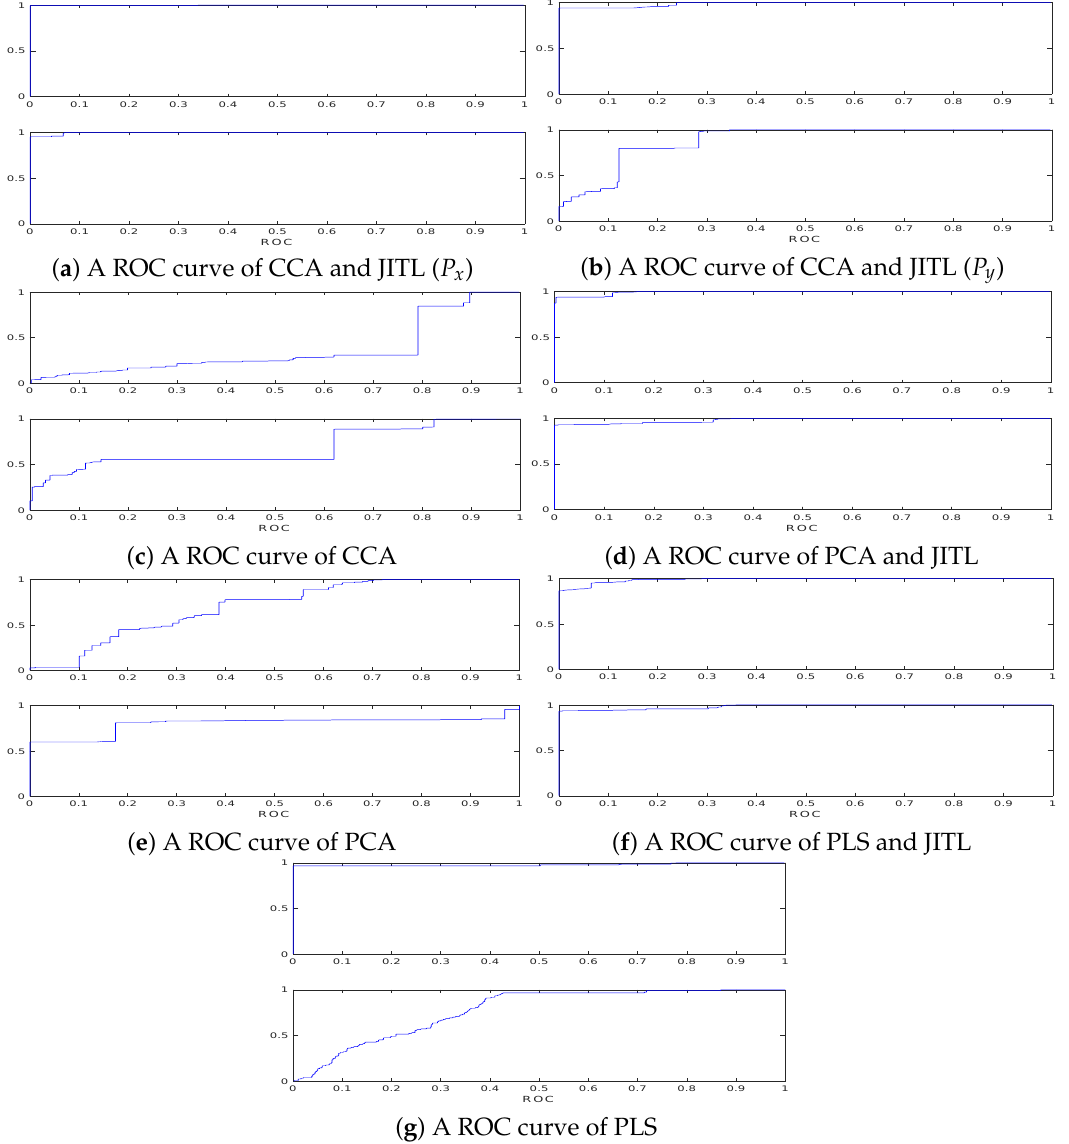
Figure 8. The ROC curves of FD models. ( a ) A ROC curve of CCA and JITL ( P x ); ( b ) A ROC curve of CCA and JITL ( P y ); ( c ) A ROC curve of CCA; ( d ) A ROC curve of PCA and JITL; ( e ) A ROC curve of PCA; ( f ) A ROC curve of PLS and JITL; ( g ) A ROC curve of PLS. Comparisons of FAR and FDR measures on FD models using CCA-JITL, CCA, PLS- JITL, PLS, PCA-JITL and PCA are shown in Table 1. By comparing FAR and FDR among all algorithms, CCA-JITL worked best for online testing. FAR and FDR scores were calculated regarding T 2 and SPE statistics, respectively. The average scores of FAR and FDR were considered to be used in the result comparison. Compared with the CCA method, the